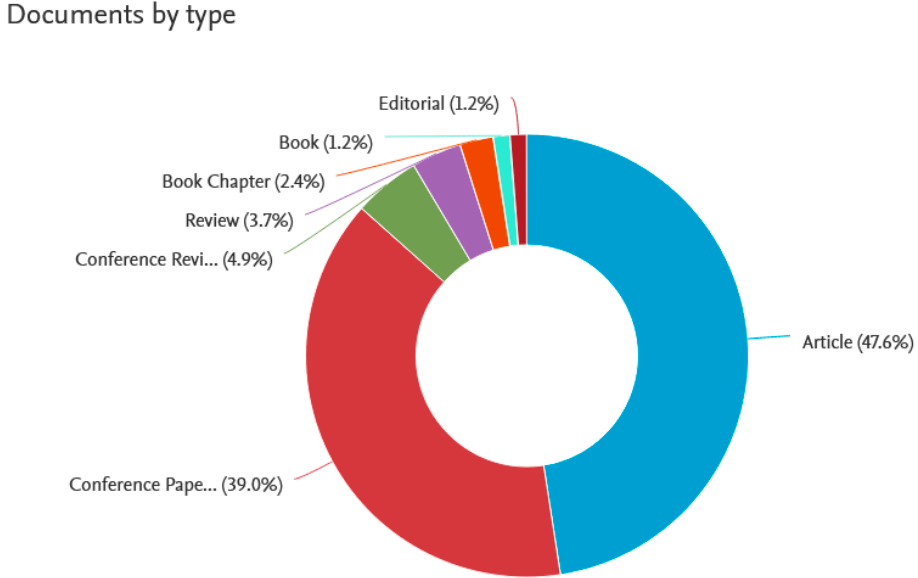
Figure 13. Documents found in Scopus for the “temporal big data” key phrase by document type.